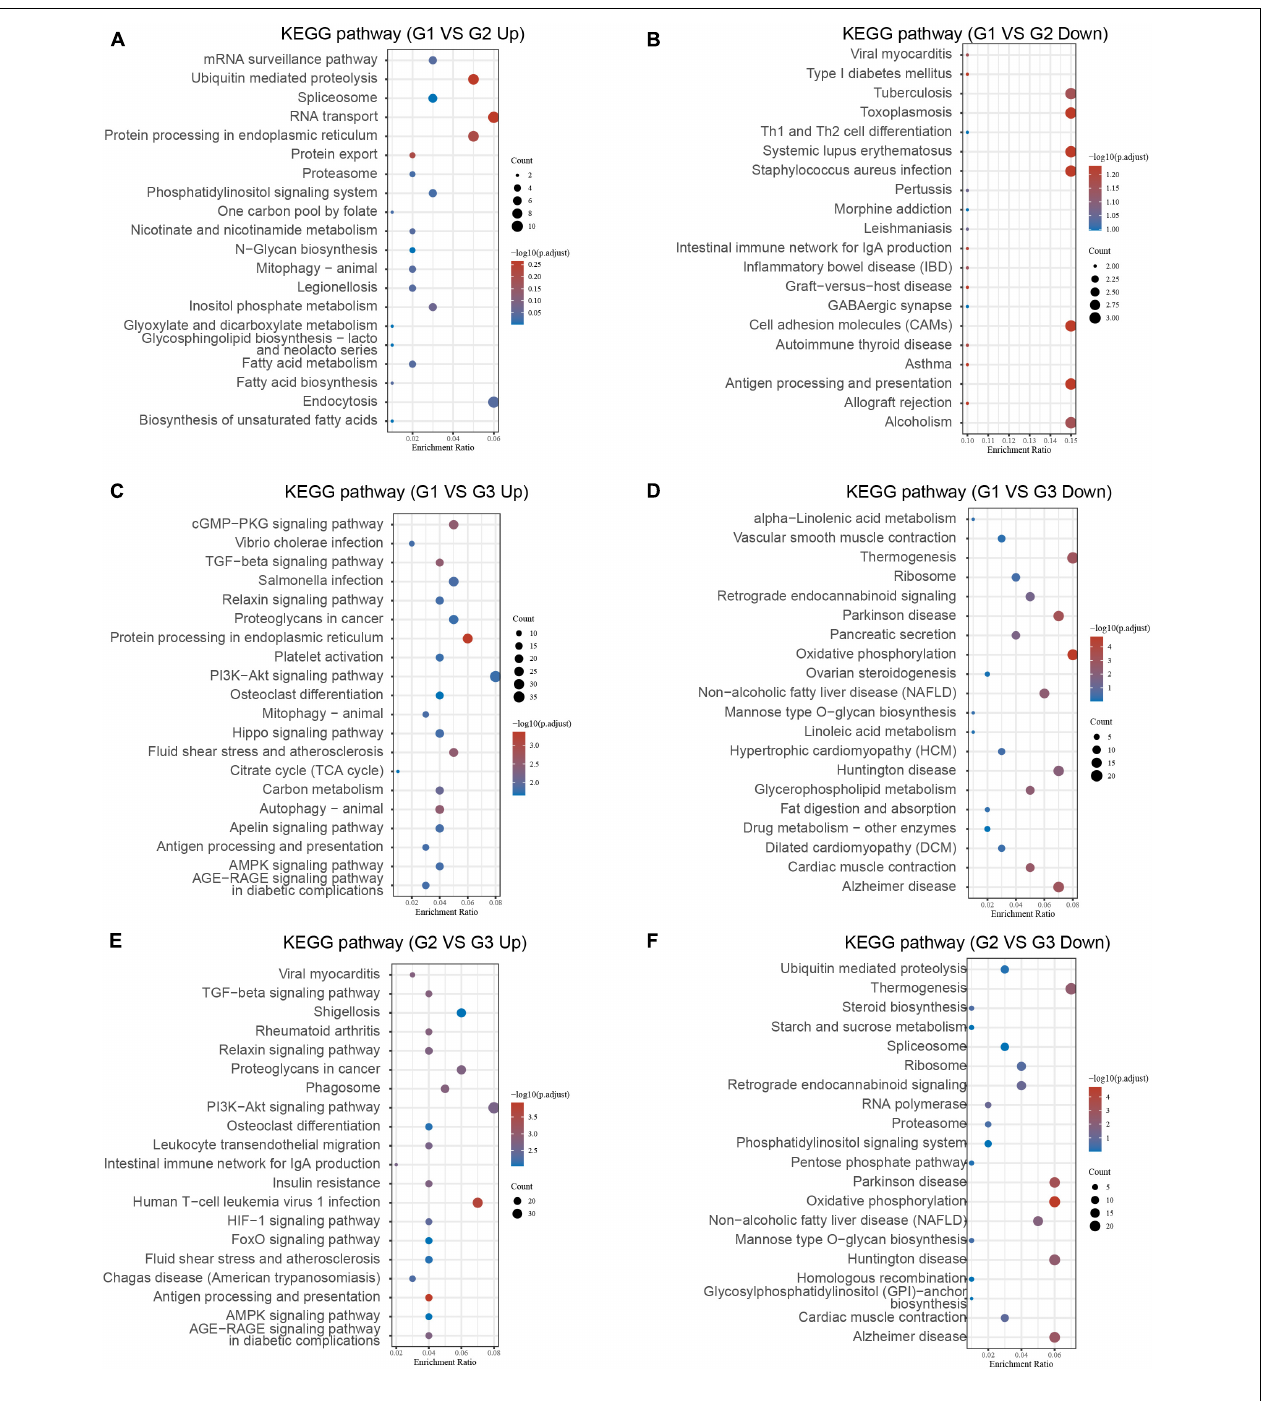
FIGURE 6 | Bioinformatics analysis of DEGs between different clusters in MI. (A–F) KEGG analysis revealed potential signaling regulated by upregulated DEGs and downregulated genes in cluster 1 MI compared with cluster 2 MI samples (A,B) , in cluster 1 MI compared with cluster 3 MI samples (C,D) , and in cluster 2 MI compared with cluster 3 MI samples (E,F)